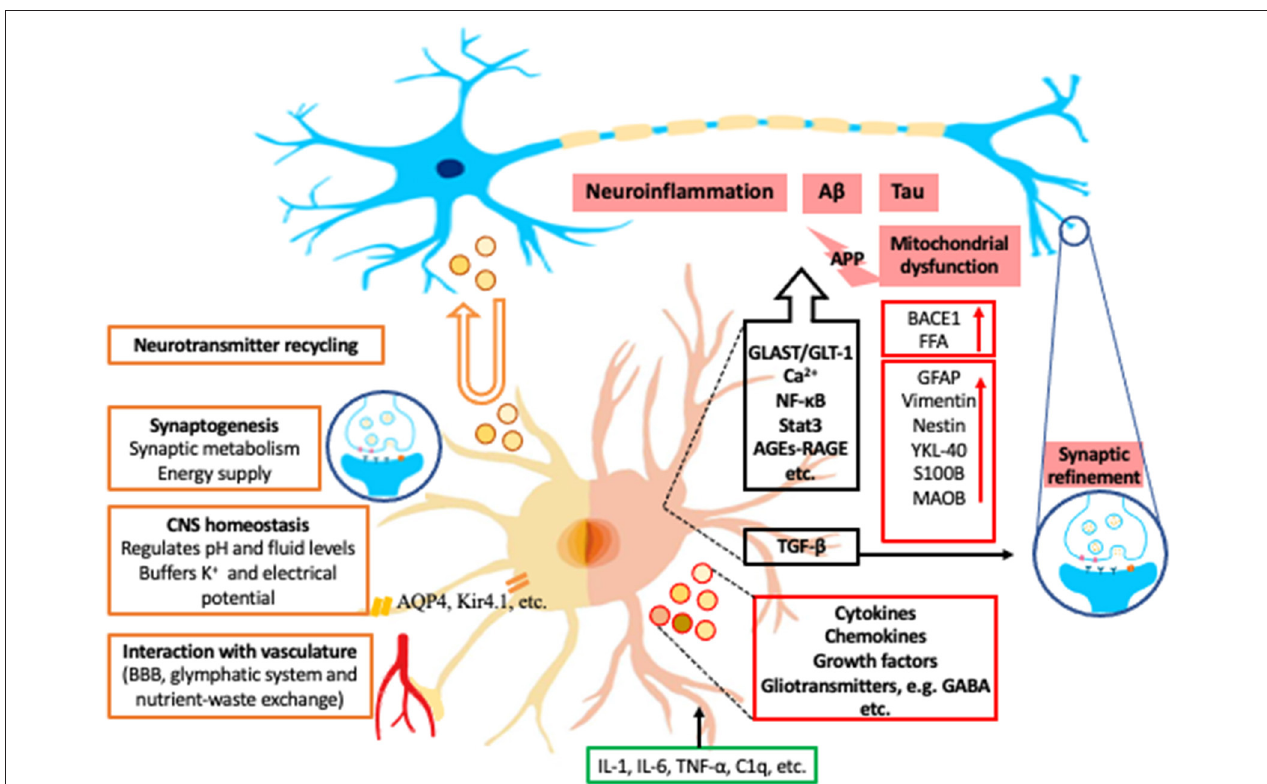
FIGURE 1 | Examples of roles of astrocytes in normal condition and in AD. The left half of astrocyte (yellow) depicts normal astrocyte functions, including neurotransmitter recycling (U-turn arrow and brown-outlined circles), synaptogenesis, central nerve system (CNS) homeostasis, and interaction with vasculature. The right half of astrocyte (Pink) depicts a reactive astrocyte in Alzheimer’s Disease (AD). The black box contains some examples of the astrocytic signaling pathways related to AD. Green box indicates examples of inducing factors of reactive astrocytes from microglia. Red boxes are the representative intracellular and secretory molecules (red-outlined circles) and astrocytic makers expressed by reactive astrocytes in AD. Blue circles with icons are synapses. K + , potassium; AQP4, aquaporin-4; Kir4.1, inwardly rectifying K + channel subunit 4.1; APP, amyloid-beta precursor protein; BACE1, β -site APP-cleaving enzyme 1; FFA, free fatty acid; GFAP, glial fibrillary acidic protein; YKL-40, chitinase-3 protein like-1; S100B, S100 calcium-binding protein B; MAOB, monoamine-oxidase-b; GLAST, glutamate aspartate transporter; GLT-1, glutamate transporter 1; Ca 2 + , calcium; NF- κ B, nuclear factor- kappa B; Stat3, signal transducer and activator of transcription 3;